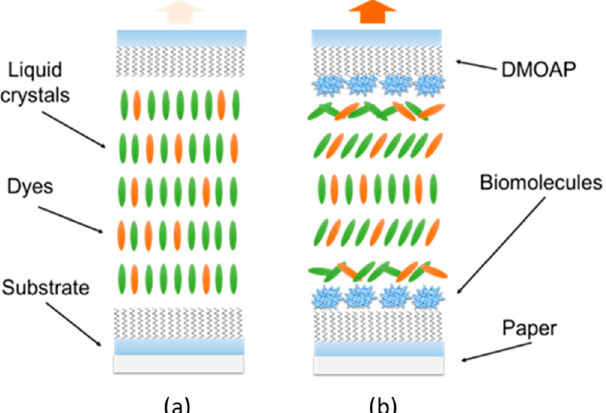
Figure 3. Schematic illustration of the DDLC-based-bioinspired sensing platform in the absence of, and immobilized with biomolecules. ( a ) without biomolecules and ( b ) with biomolecules.